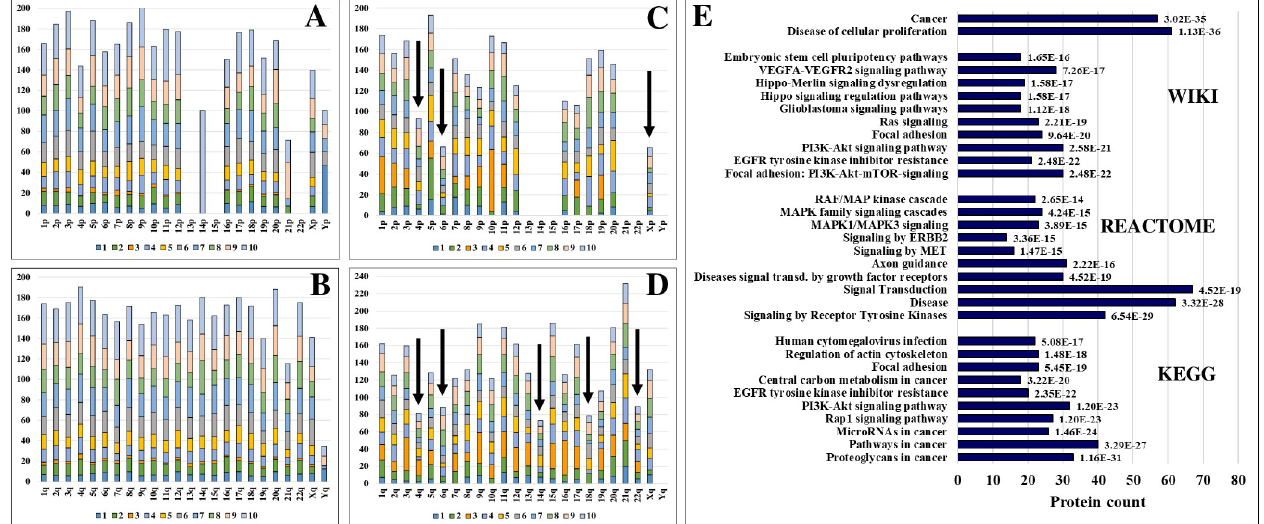
Fig 2. Stacked bar charts representing cancer-supportive human genes and proteins distributed per chromosome arms and per cancer hallmarks. The vertical ordering of hallmarks is following the same numerical trend as in Fig 1B (1-chart bottom, 10-chart top). ( A ) and ( B ) represent % cell-membrane protein-coding genes out of total coding genes per chromosome and p/q arms (the summed percentages exceed 100 because of genes with contributions to multiple hallmarks); ( C ) and ( D ) represent % cell-membrane proteins detected in SKBR3 out of total encoded; ( E ) Bar chart of top biological processes and pathways represented by the 138 subset of hallmark proteins (bar chart labels indicate